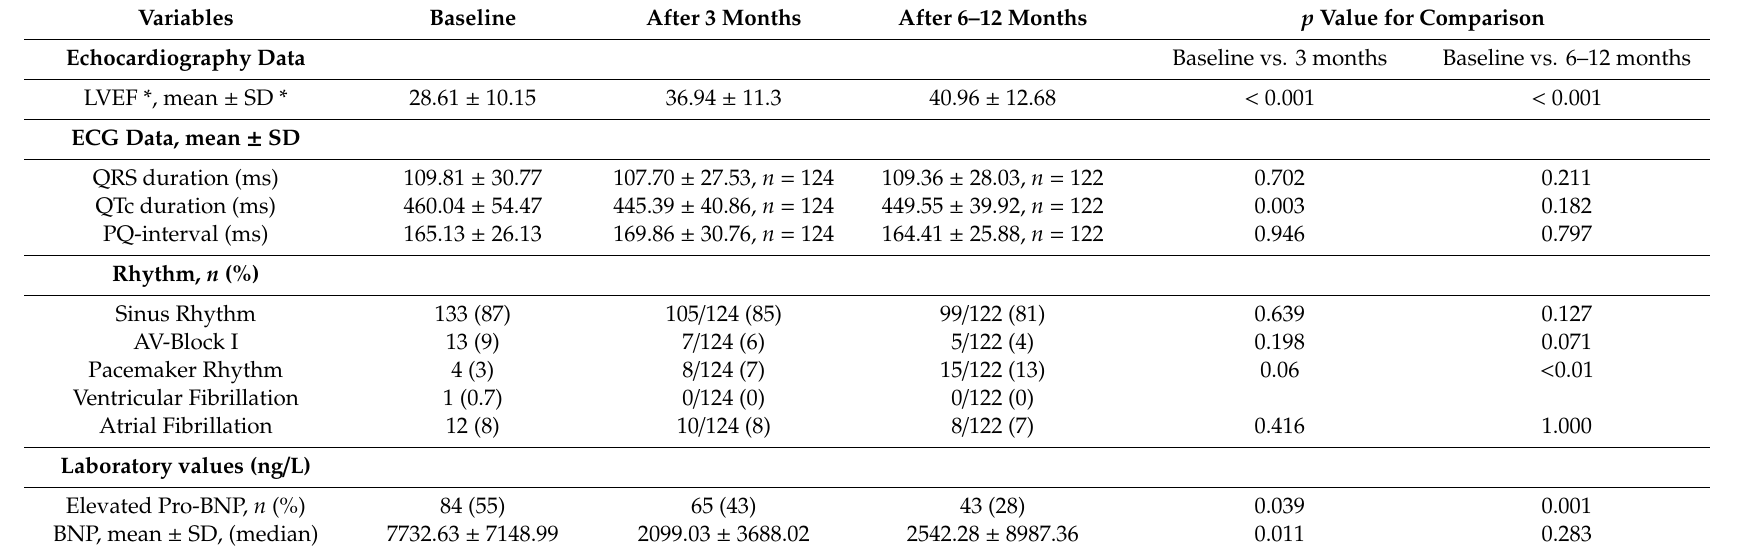
Table 3. Follow up clinical data of patients with wearable cardioverter defibrillator (WCD), n =